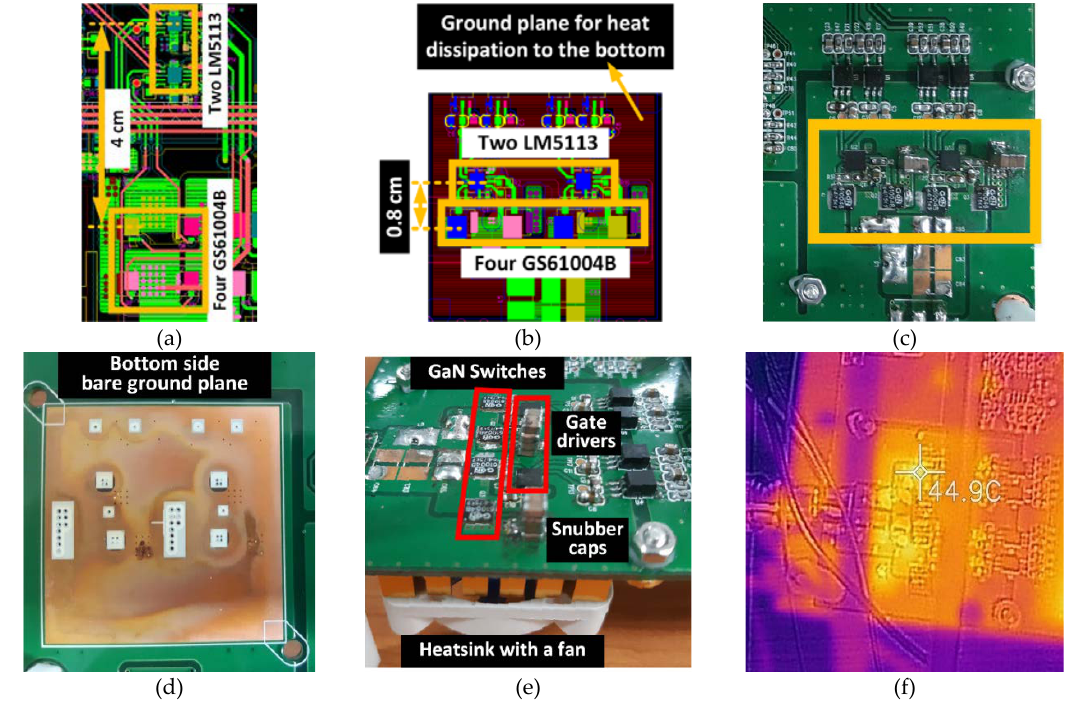
Figure 11. Configuration of the WPT system: ( a ) Initial design; ( b ) Revised design; ( c ) Fabricated inverter; ( d ) Bottom side ground plane; ( e ) Assembled heatsink and a fan; ( f ) Thermal image of the inverter at 81-W